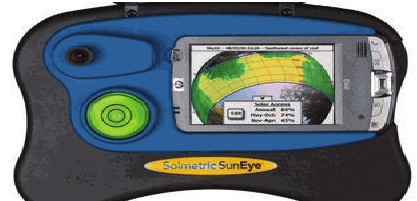
Figure 4: An electronic horizon and obstacle catcher (photo courtesy of Sun